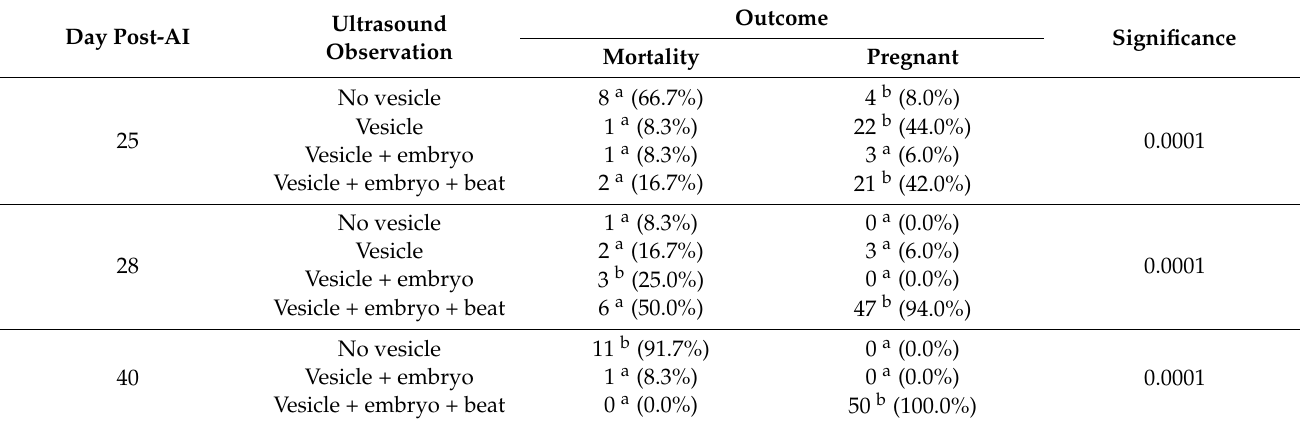
Table 1. Results of ultrasound observations according to number of days post-artificial insemination (AI) and outcome. Day